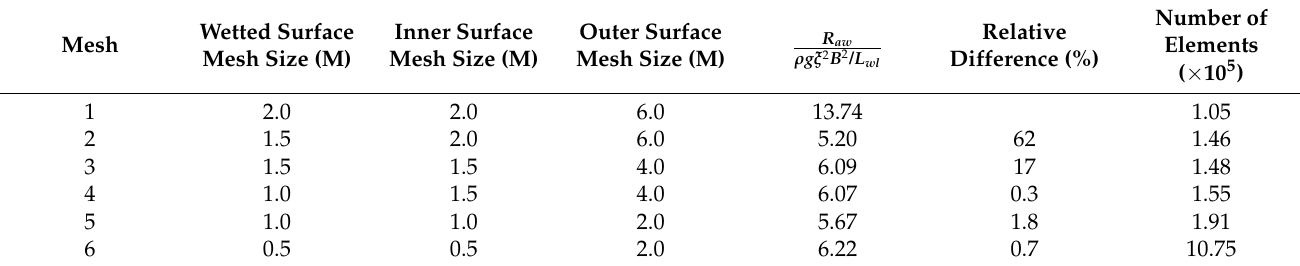
Table 6. Relative error for different meshes of dimensionless added wave resistance in regular airy